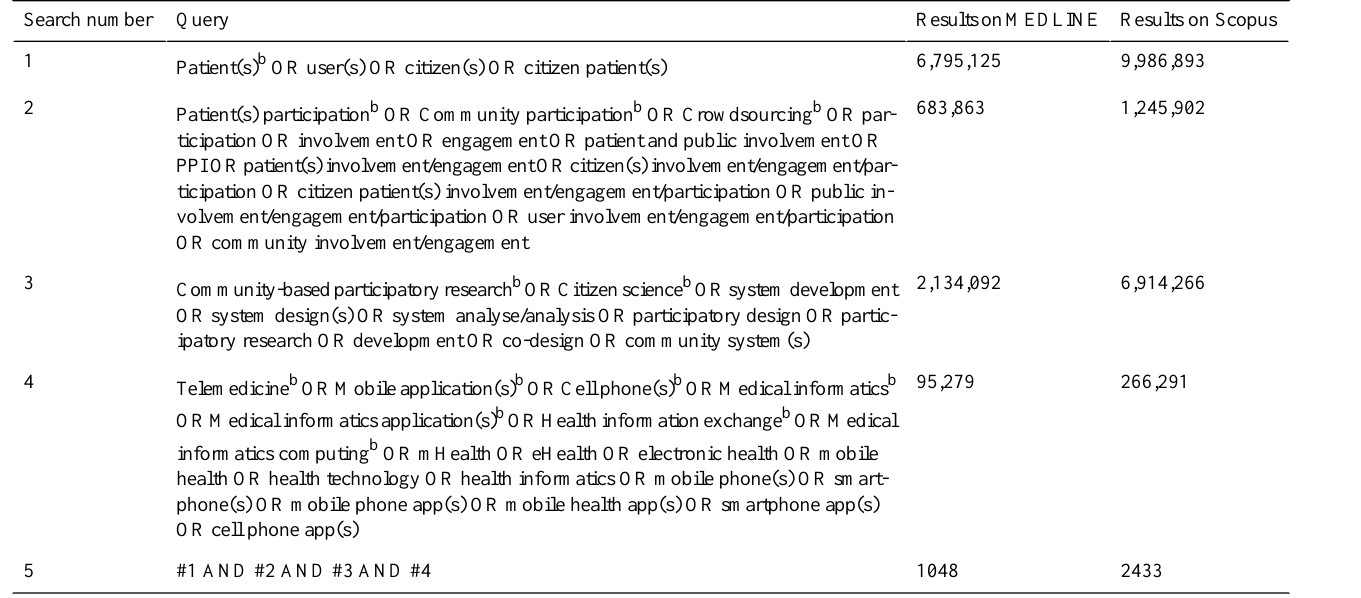
Table 1. Preliminary search on Scopus and MEDLINE. a